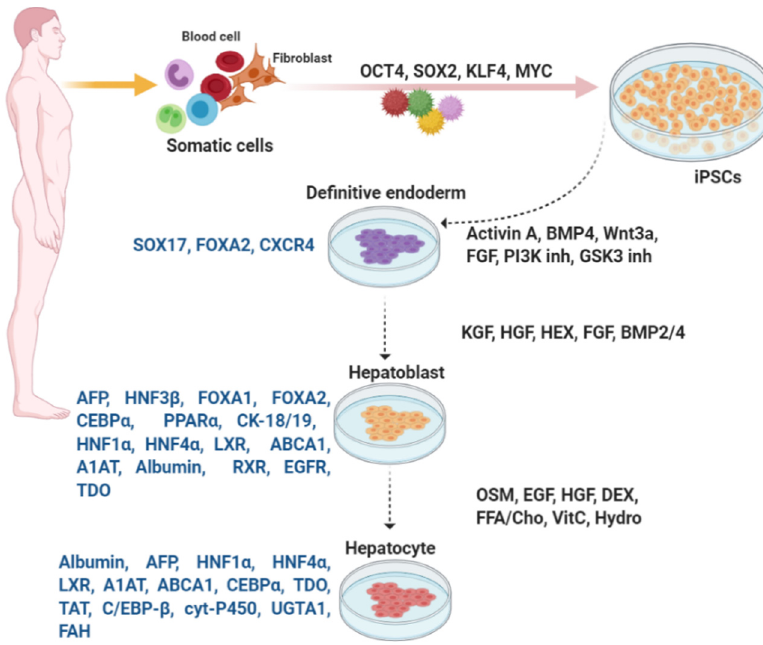
Figure 3. In vitro differentiation of hepatocytes from iPSCs. Similar to differentiation of β -like cells, embryonic development is mimicked by addition of numerous large or small molecules to induce each stage of differentiation. Expression of the key transcription factors is monitored for evaluation of the consecutive stages of differentiation.